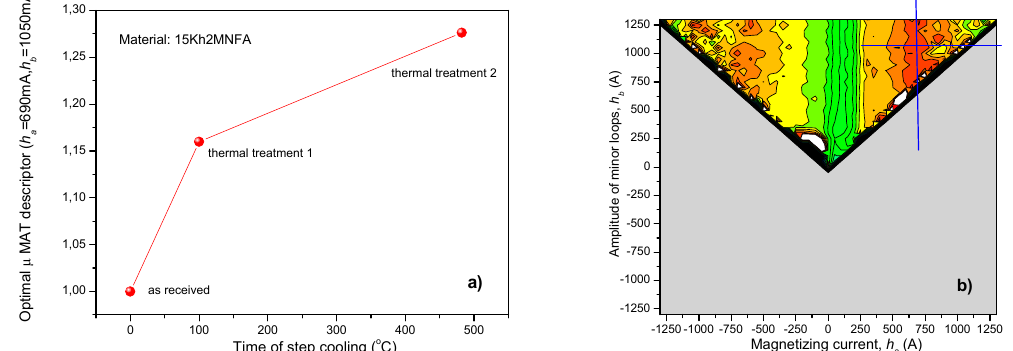
Figure 5. ( a ) Optimally chosen normalized Magnetic Adaptive Testing (MAT) descriptor as a function of the time of step cooling for 15Kh2NMFA material; ( b ) the corresponding map of sensitivity, which shows the position of this descriptor.